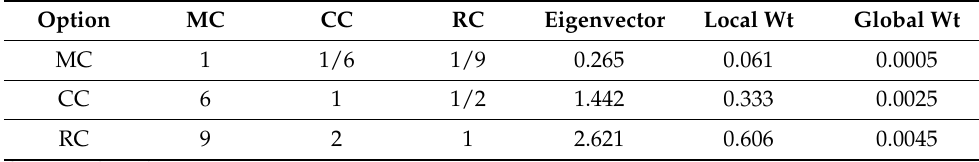
Table A20. Comparison of alternatives matrix for subcriterion